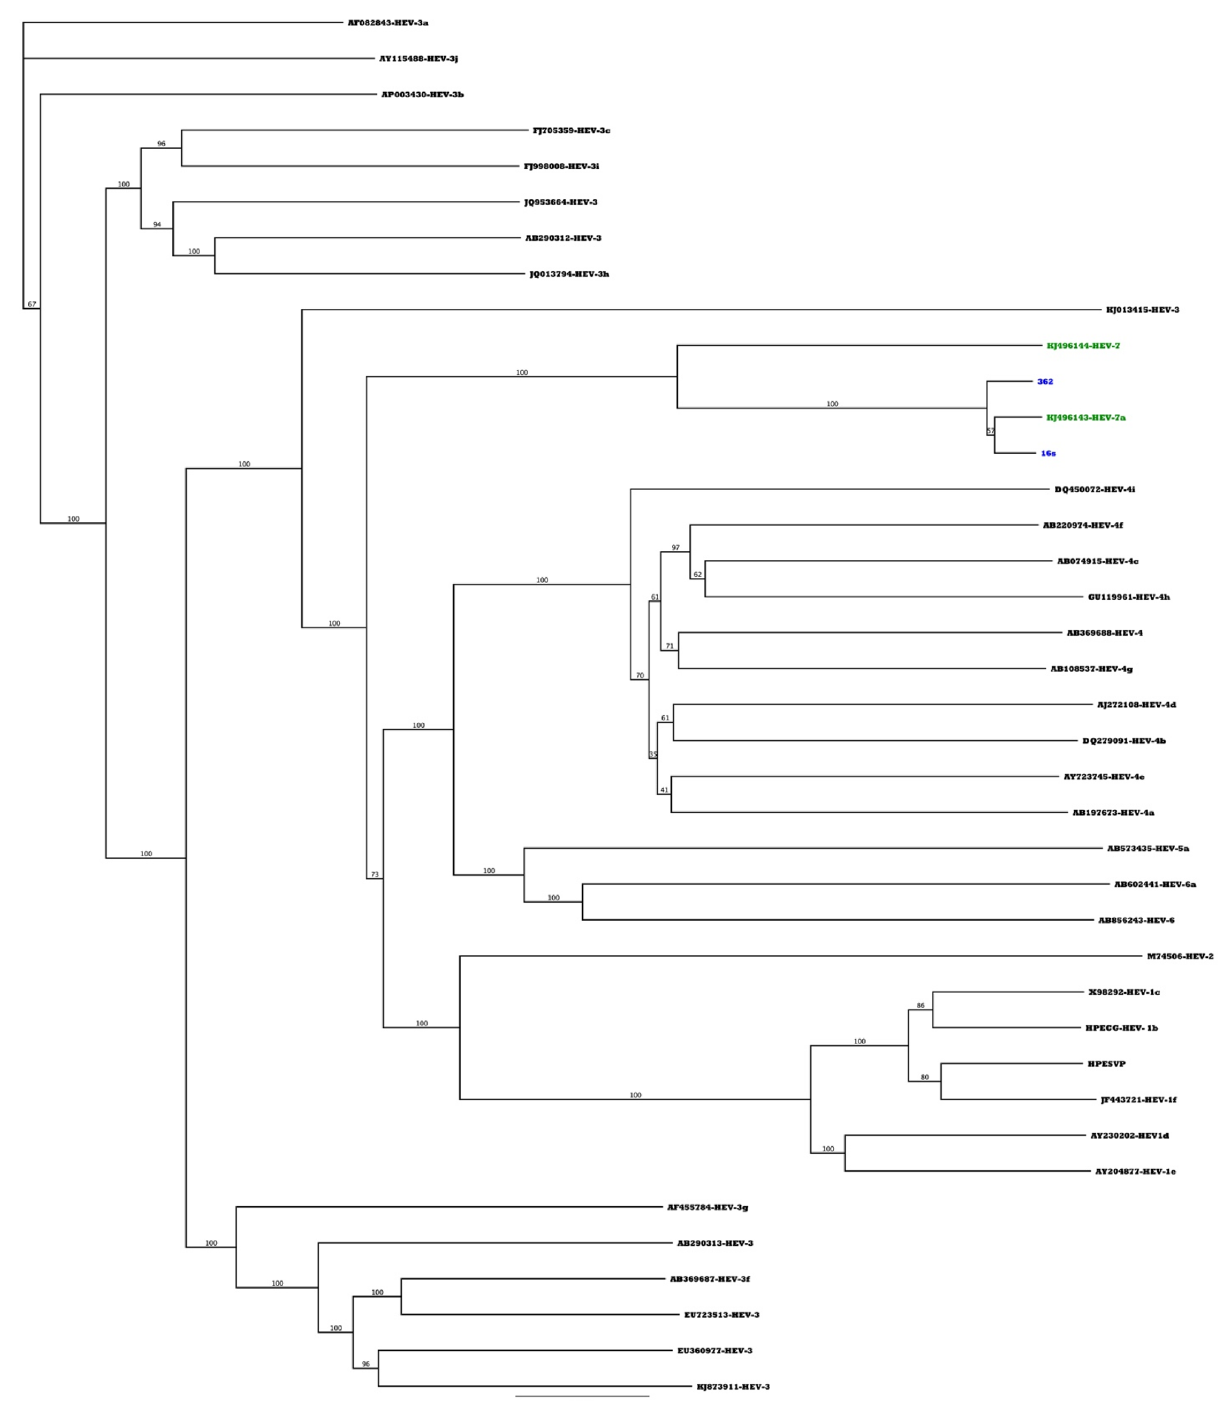
Figure 2. Phylogenetic tree for the two full genome sequences generated in the study. Blue-colored labels represent the new sequences from this study, while the blue-colored labels represent the two full genome reference sequences available in the Genbank. Phylogenetic tree was constructed using Maximum Likelihood method with 1000 bootstrap replicates using Geneious prime software (version